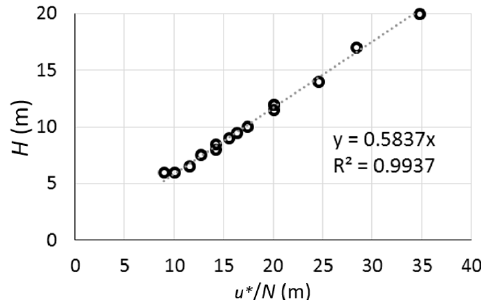
Figure 10. Scenario B. Initial thickness, H , of the surface mixed layer plotted against the length scale u* / N , where u*= ( τ x / ρ o ) 1/2 is the wind-friction velocity. Shown are the results of 15 different model configurations for wind-stress magnitudes between 0.05 and 0.15 Pa and values of N 2 ranging between 1 × 10 −4 s −2 and 5 × 10 −4 s −2 .